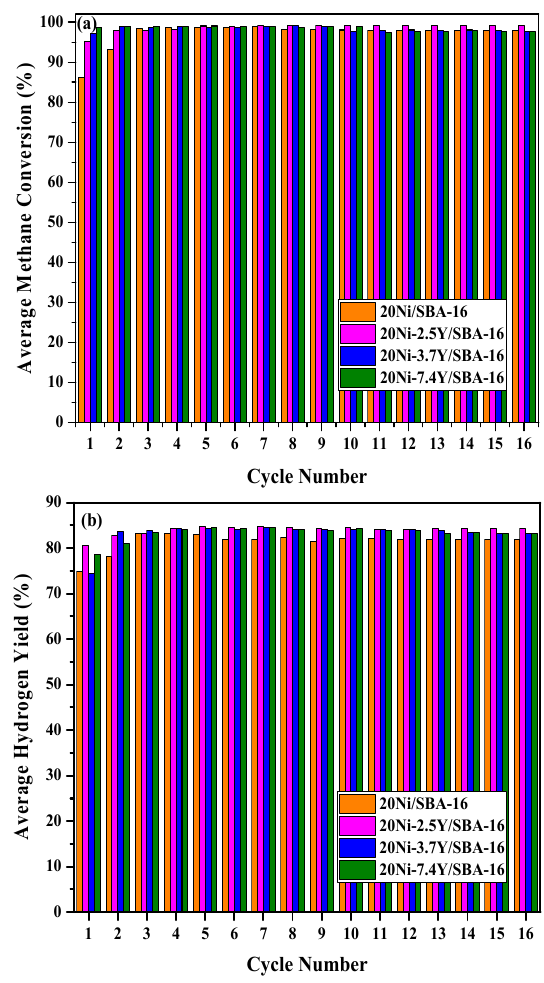
Figure 7. The Life time of 20Ni ‐ yY/SBA ‐ 16 oxygen carriers at 650 °C: ( a ) Average methane conversion and ( b ) Average hydrogen yield.